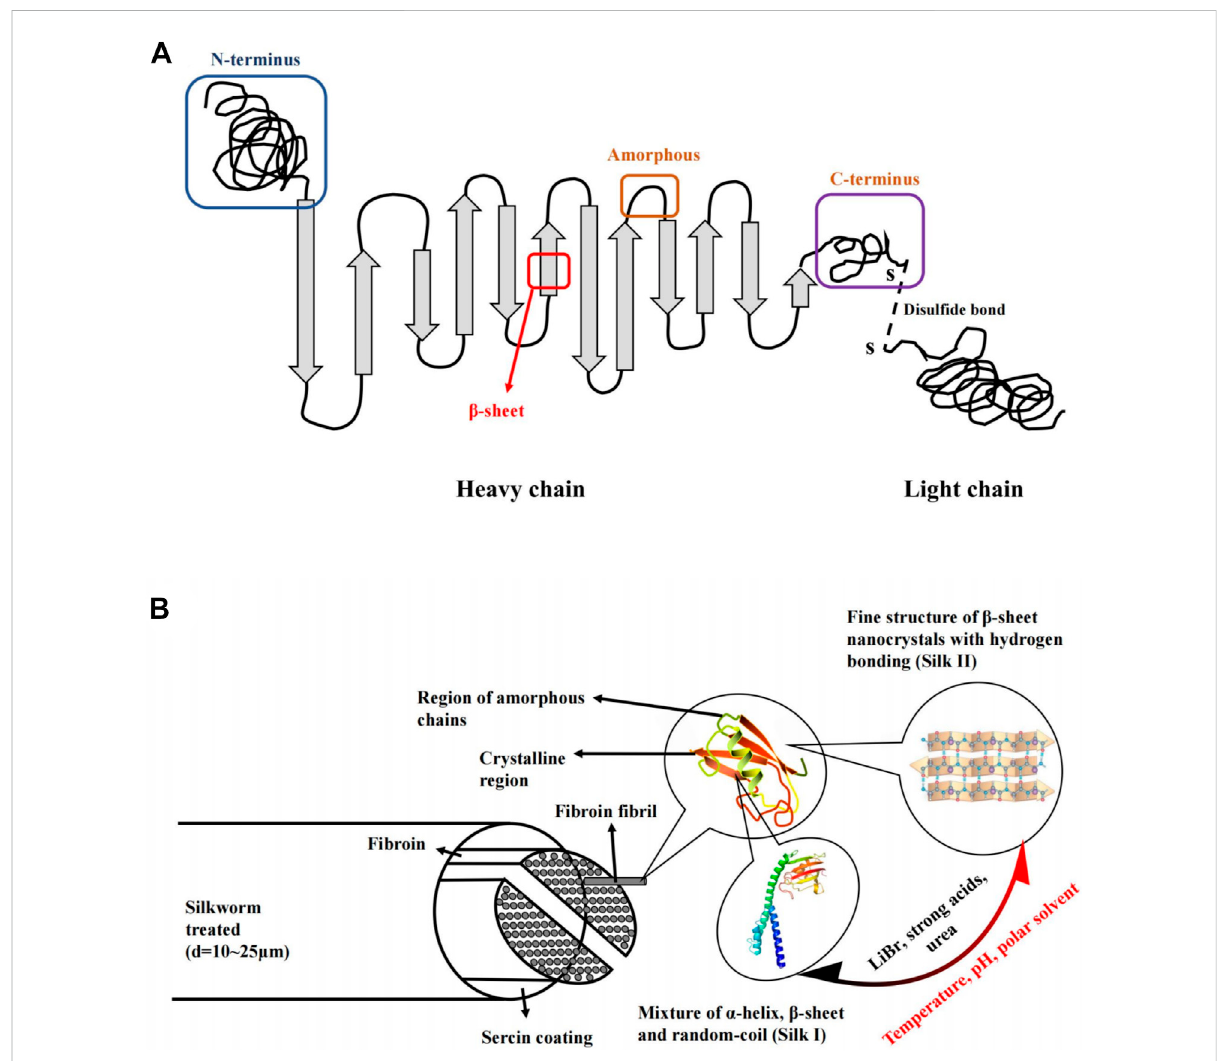
FIGURE 1 Schematicdiagramofthesilkstructure. (A) heavychain(i.e.,N-terminus, β -sheets,AmorphousandC-terminus).andlightchainwhichlinked via disulphide bonds. (B) silkwormthread, fi bril overall structureand silk fi broinpolypeptidechains.Notes: Sun, W., Gregory,D.A.,Tomeh,M.A., Zhao, X., 2021. Silk fi broin as a functional biomaterial for tissue engineering. International Journal of Molecular Sciences 22, 1499. Reprinted with permission from references. Copyright 2021,